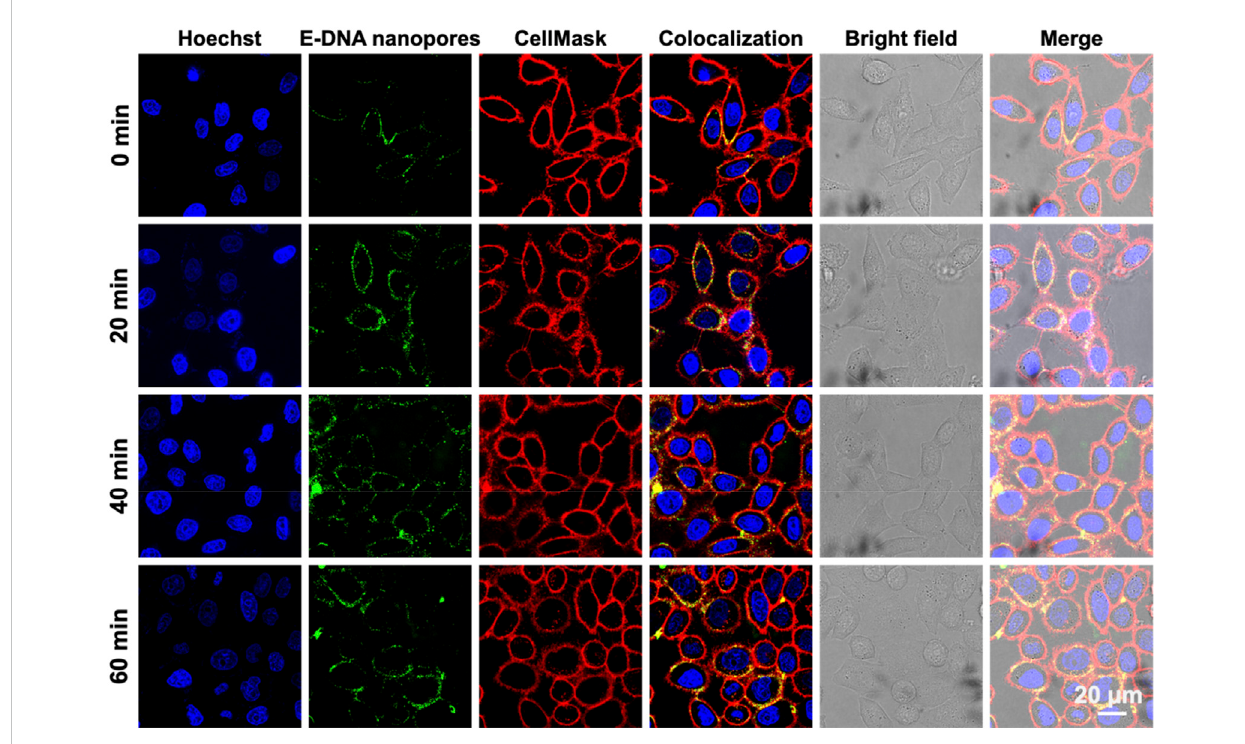
FIGURE 4 Confocal images of MCF-7 cells incubated with E-DNA nanopores at different times. Scale bar: 20 μ